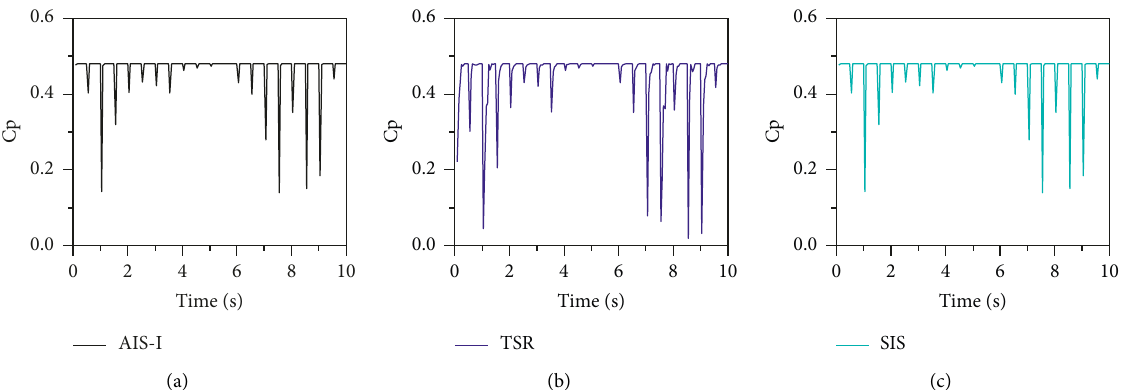
C p based on the AIS-I method, (b)